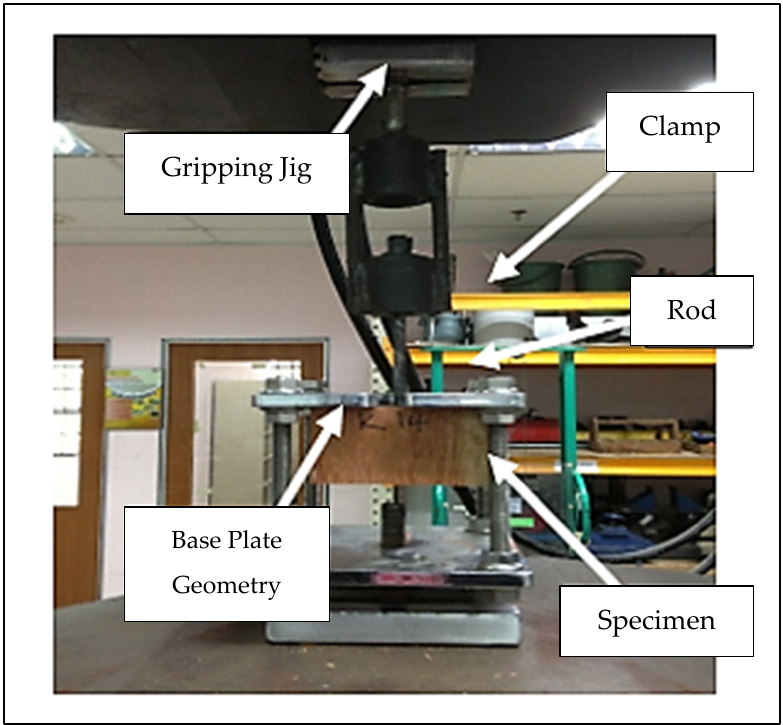
Figure 2. Pull-out Test Set Up.